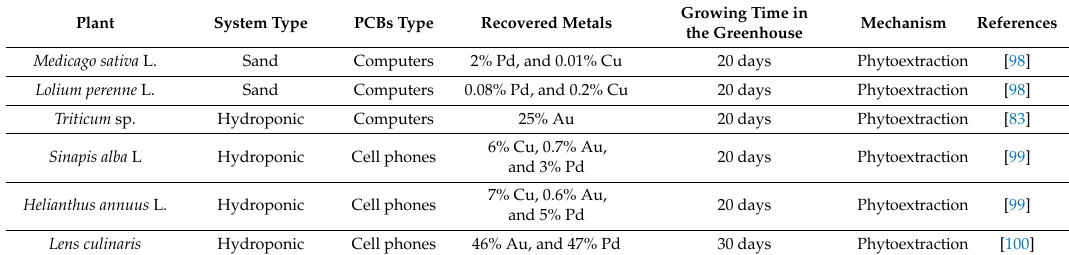
Table 4. Plants used in the recovery of metals from PCB of computers and cell phones. Plant